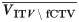
Margin evaluation measurements.The CTV (red) is propagated to the fraction control CT image (fCTV, orange) to calculate CTV volume missed by the treatment VfCTV \ ITV and the volume of healthy tissue being hit VITV \ fCTV¯.